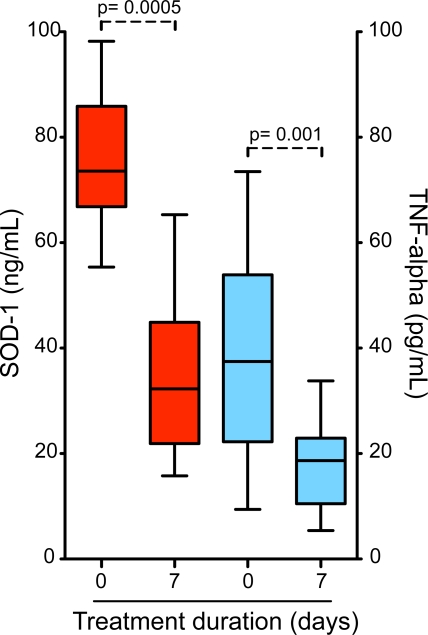
Effect of anti-malaria treatment on plasma concentrations of SOD-1 and TNF-alpha in individuals with severe vivax malaria.Plasma levels of SOD-1 protein (red boxes, left Y axis) and TNF-alpha (blue boxes, right Y axis) were estimated before treatment (at admission to the Hospital) and after seven days of in-hospital treatment with intravenous quinine and hemodynamic support in individuals with severe vivax infection who successful recovered (n = 13). Boxes represent median and interquartile interval; whiskers represent maximum and minimum values. Wilcoxon matched pairs test was performed to calculate the statistical significance. P values are plotted in each graph.